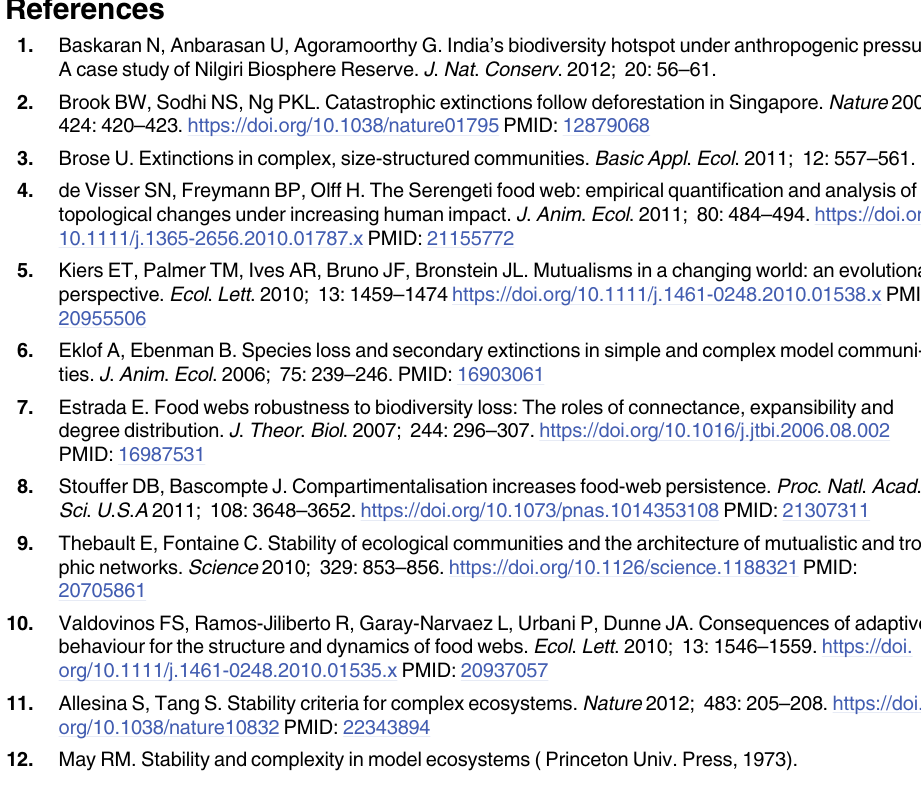
S4 Table. Correlations between different levels of robustness to the removal of specialist species and each of nine variables that describe of network structure. S5 Table. Variance explained measured by adjusted R 2 from the generalised additive model fitting of robustness on specific models for different levels of robustness. S6 Table. Pearson’s correlation coefficients for different